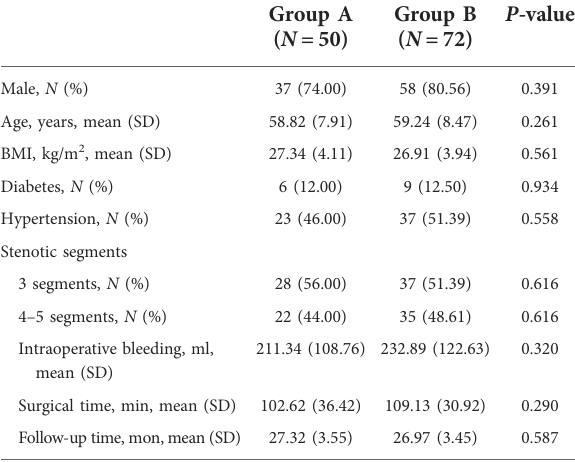
TABLE 1 Clinical summary of 122 patients with CSM.